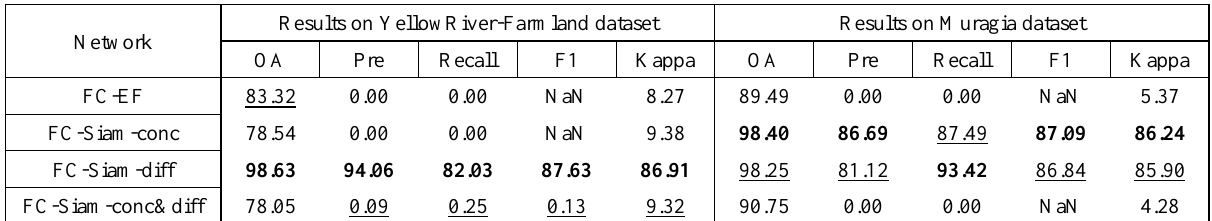
Table 4. Change detection results for different pretrained networks, YellowRiver-Farmland dataset (left) and optical Muragia dataset (right). Pre and F1 representative precision and F1-score respectively. The best results are marked in bold and the second-best results are